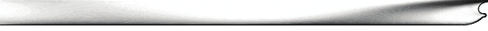
Figure 4: MOERI container ship (KCS)